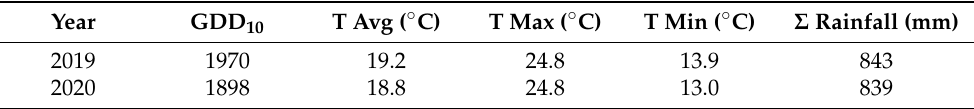
Table 2. Climate data in the experimental site during the growing season (1 April–31 October) in